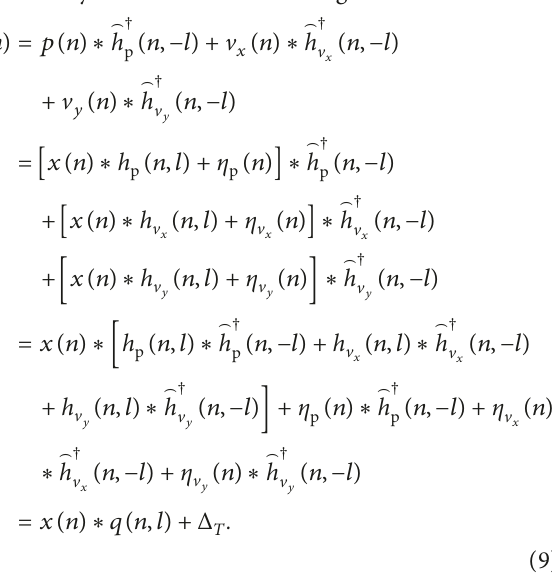
Figure 2: The block diagram of acoustic intensity